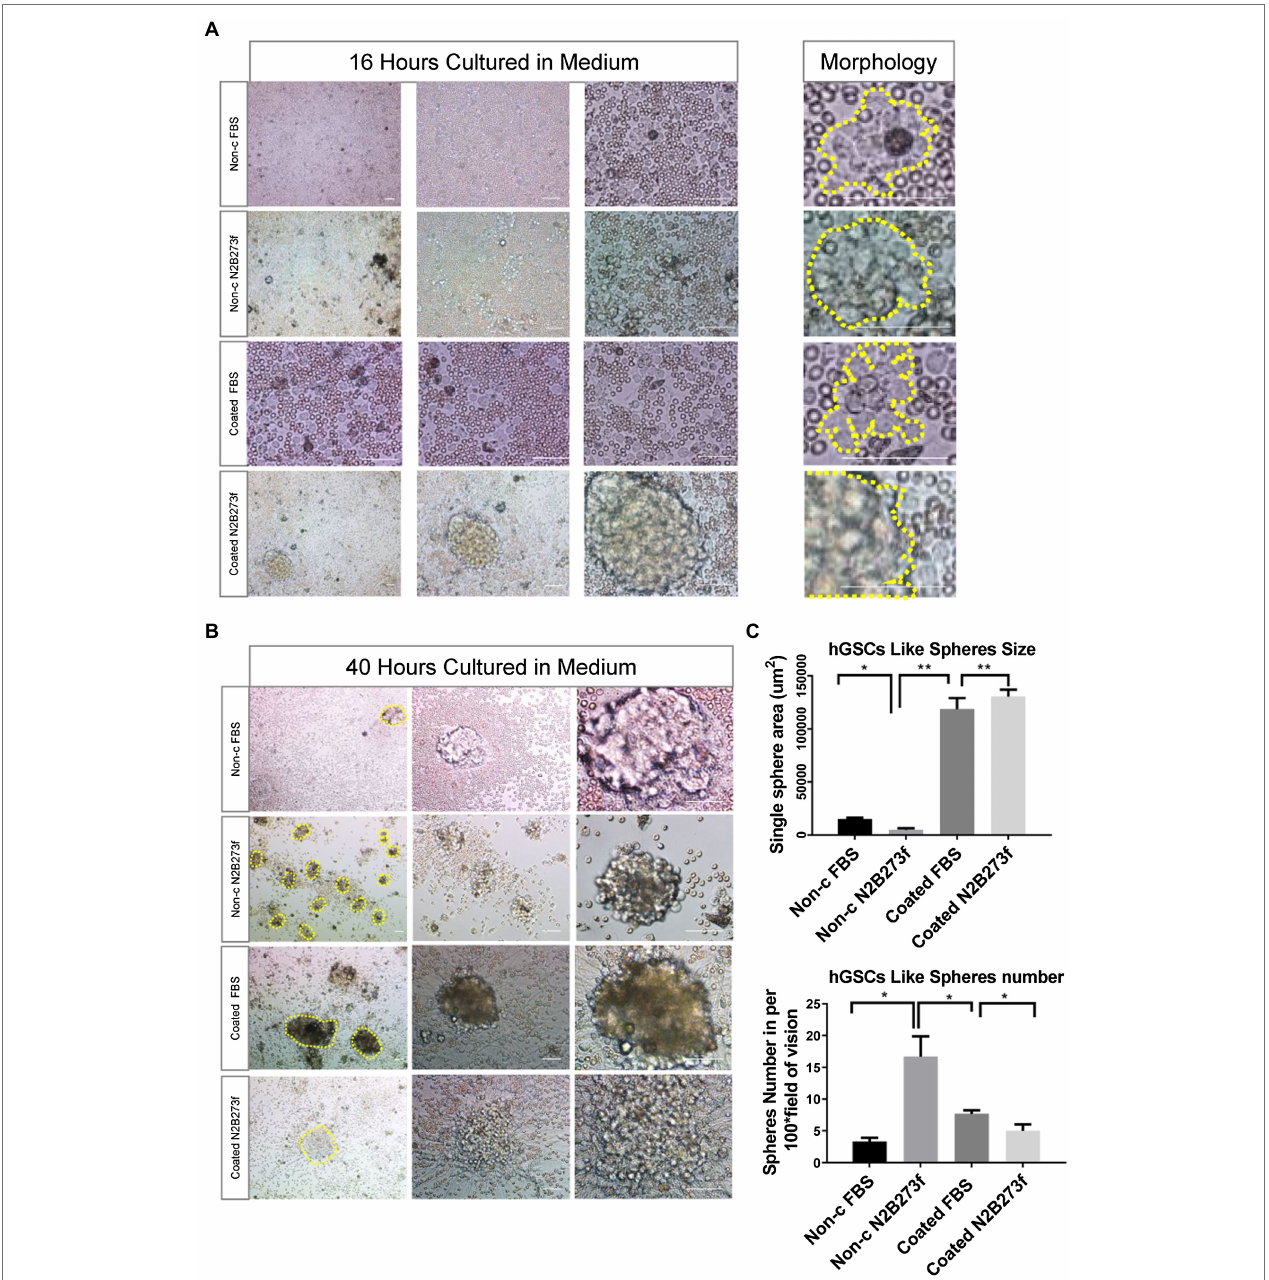
FIGURE 2 | Separating hGSCs using different methods to identify an efficient and high-quality approach. (A) Representative photos of glioma tissue cell germination and morphology following culture in a different medium for 16 h. Yellow dotted line on the right shows the clonal morphology after 16 h germination under different culture conditions. Non-c FBS: culture cells on non-coated plates with DMEM + 10%FBS; Non-c N2B273f: culture cells on the non-coated plates with DMEM/F12 + N2B27 + 3 factors [Fibroblast growth factor (FGF), epidermal growth factor (EGF), and heparin]; coated FBS: culture cells on coated plates with DMEM + 10% FBS; coated N2B273f: culture cells on coated plates with DMEM/F12 + N2B27 + 3 factors (FGF, EGF, and heparin). (B) Primary glioma cells from glioma tissue cultured in a different medium for 40 h. (C) Single sphere area and spheres number of hGSCs in per 100x field of vision (non-c FBS with n = 3; Non-c N2B273f with n = 5; coated FBS with n = 3; and coated N2B273d with n = 3). Scale bar, 50 μ m. Data are represented as mean ± SD. Student’s t -test; * p < 0.05; ** p <